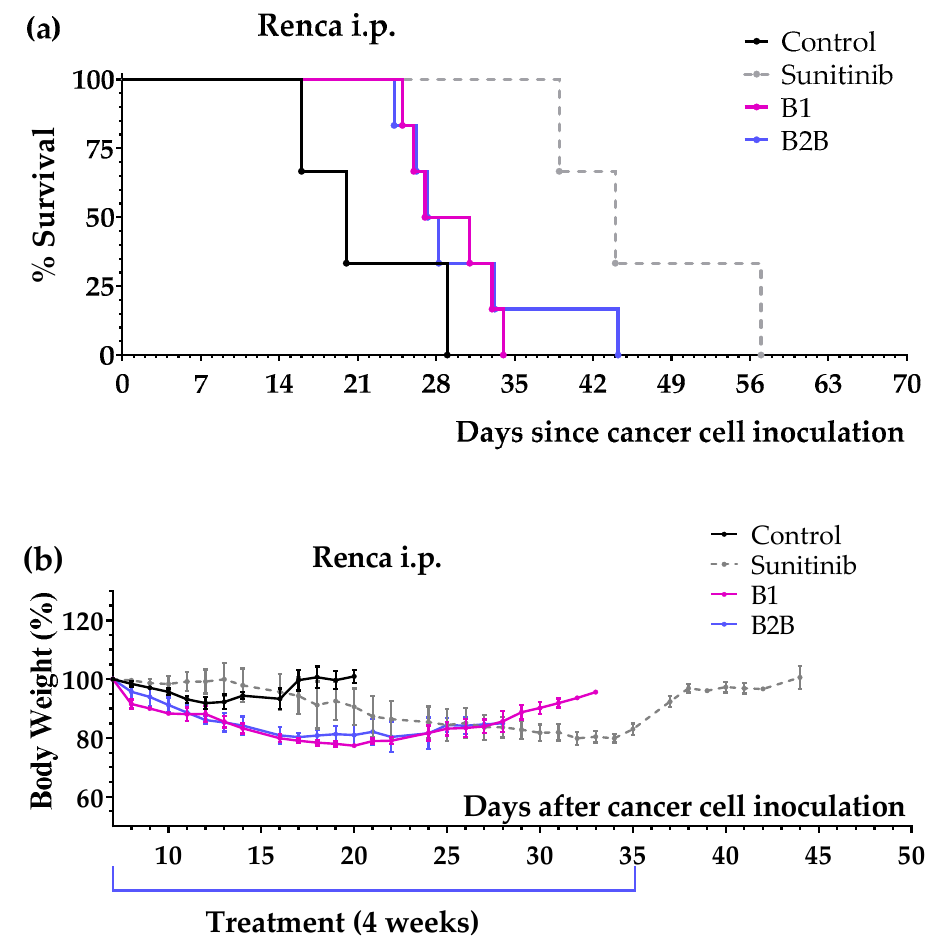
Figure 2. Anticancer activity of several artificial diets and sunitinib in mice with peritoneally disseminated renal cell carcinoma (Renca cells in BALB/c mice). ( a ) Survival of untreated mice (control), mice treated with oral sunitinib (60 mg/kg/day for 4 consecutive weeks) and mice treated with diets B1 and B2B for 4 weeks. ( b ) Body weights of mice (mean percentage ± SEM) relative to body weights at the beginning of the treatments (day 7). Table 2. Survival of mice with peritoneally disseminated renal cell carcinoma treated with sunitinib and diets B1 and B2B.